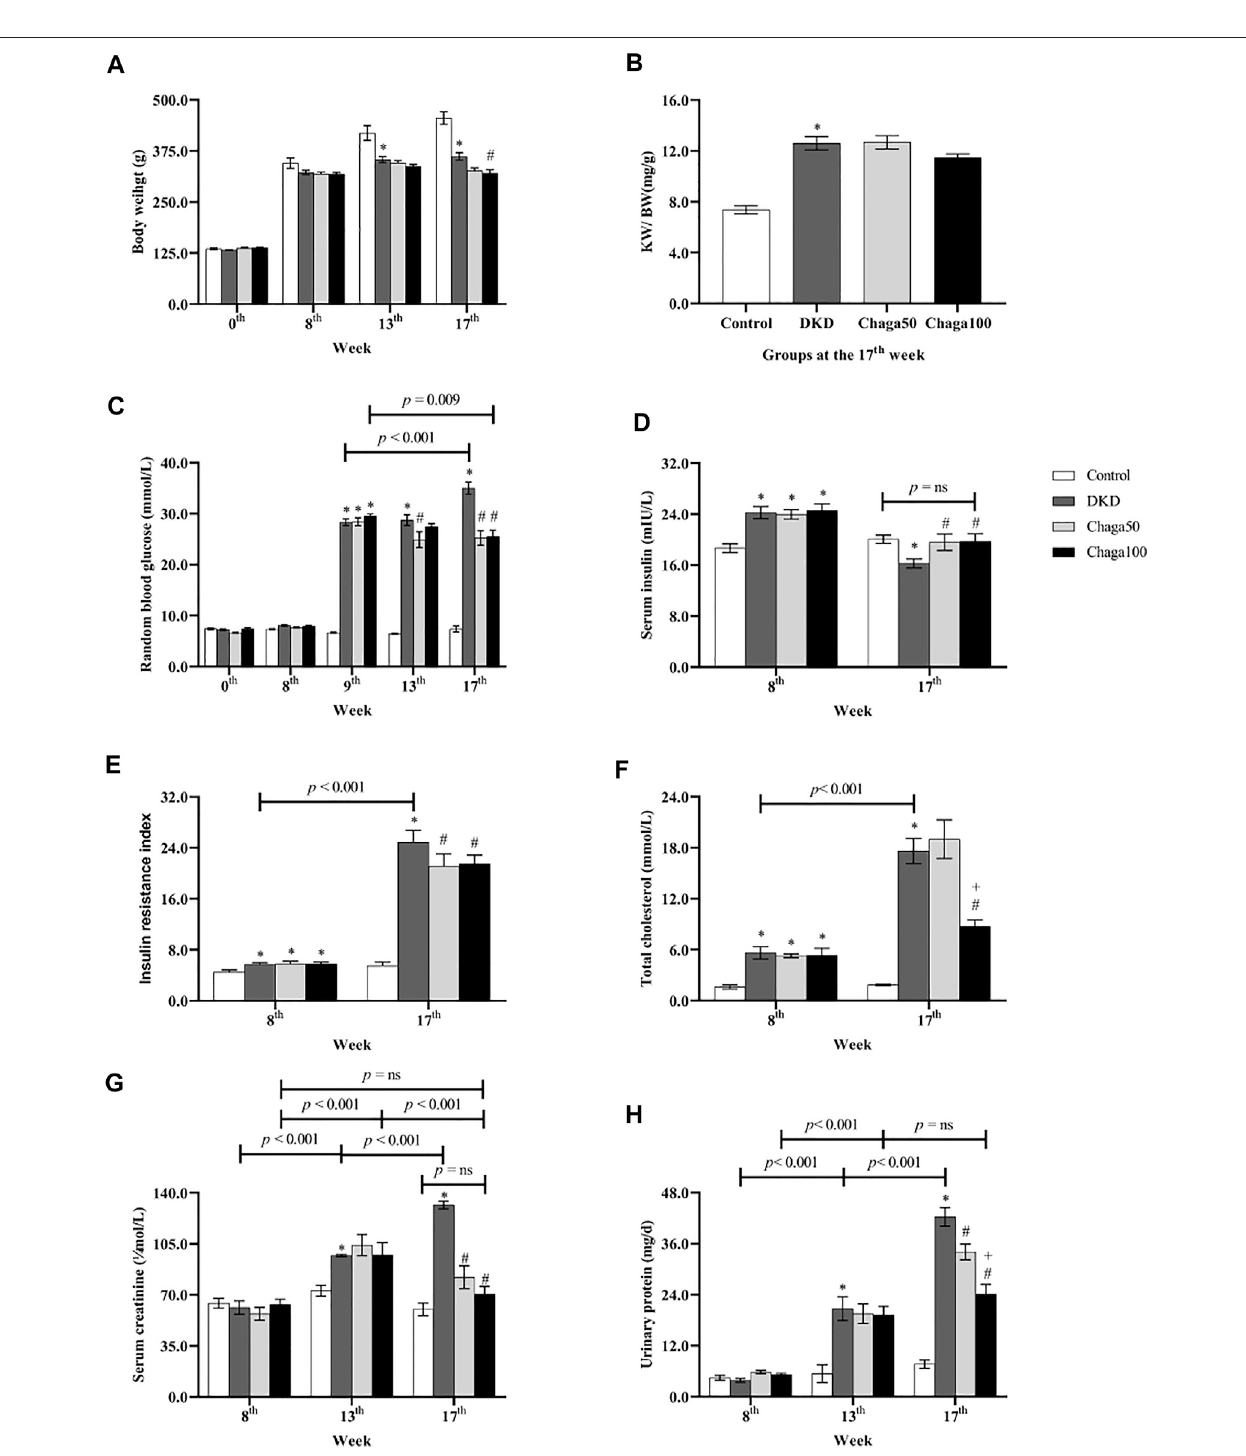
FIGURE 3 | Biological parameters among four groups in different week. (A) Body weight of rats in each group. (B) The ratio of KW/BW of rats in each group. (C) Blood glucose of rats in each group. (D) Serum insulin of rats in each group. (E) Insulin resistance index of rats in each group. (F) Total cholesterol of rats in each group. (G) Serum creatinine of rats in each group. (H) Urinary protein excretion of 24 h in each group. Data were presented as mean ± SE. DKD, diabetic kidney disease; Chaga50, treatment with 50 mg/kg of chaga group; Chaga100, treatment with 100 mg/kg of chaga group; KW/BW, kidney weight/body weight. * p < 0.05 vs. Normal control group, # p < 0.05 vs. DKD group, + p < 0.05 vs. Chaga50 group.